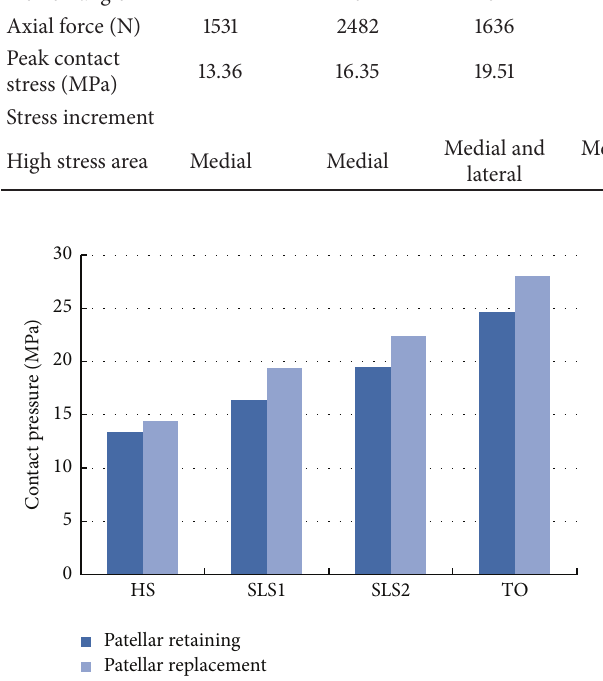
Figure7:HistogramofthemaximalcontactstressoftheUHMWPE tibial tray during the gait cycle.